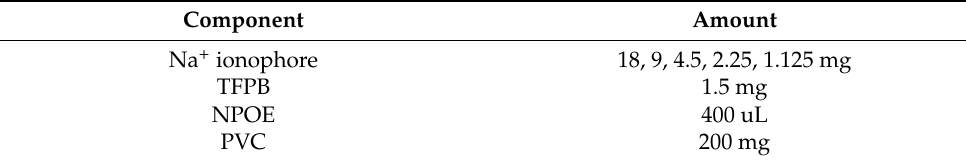
Figure 1. Structure of reagents: ( a ) TFPB. ( b ) NPOE. ( c ) Bis[(12-crown-4)methyl] 2-dodecyl-2- methylmalonate (Na + ionophore). Table 1. Components and concentrations of